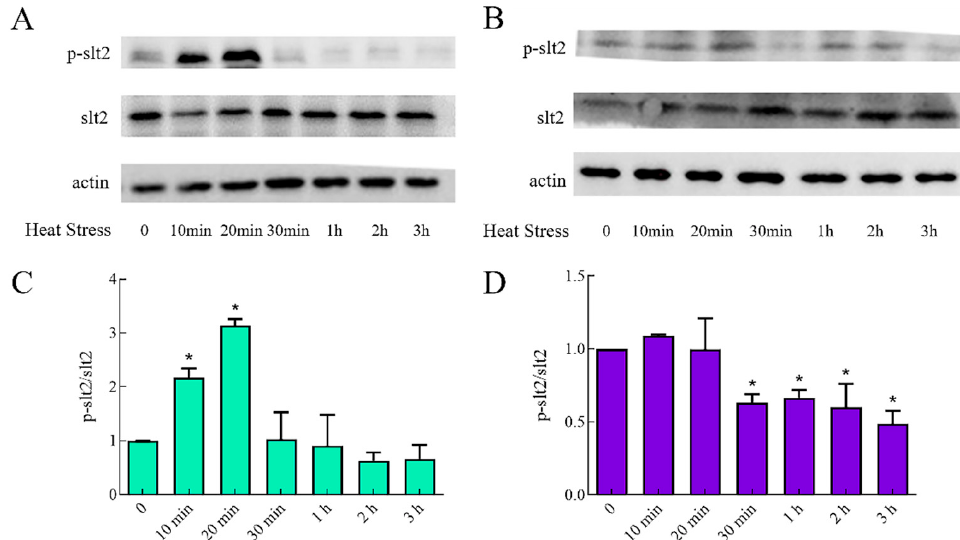
Figure 5. Effects of Silencing HMX1 on slt2 MAPK. The p-slt2/slt2 of WT and HMX1i strains under different heat shock times were as illustrated in ( A , B ), respectively. Quantification of p-slt2/slt2 levels in WT and HMX1i strains at different heat shock times are shown in ( C , D ). Error bars are repre- sented as mean ± SEM. Significance was accepted at * p <0.05. The same as follows.